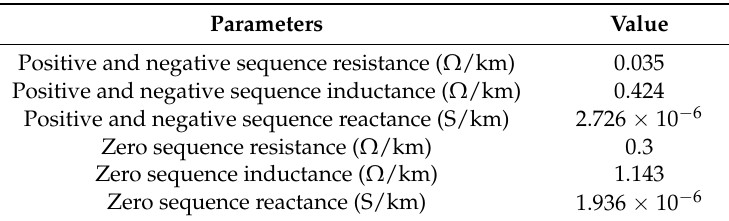
Table 1. Parameters of transmission